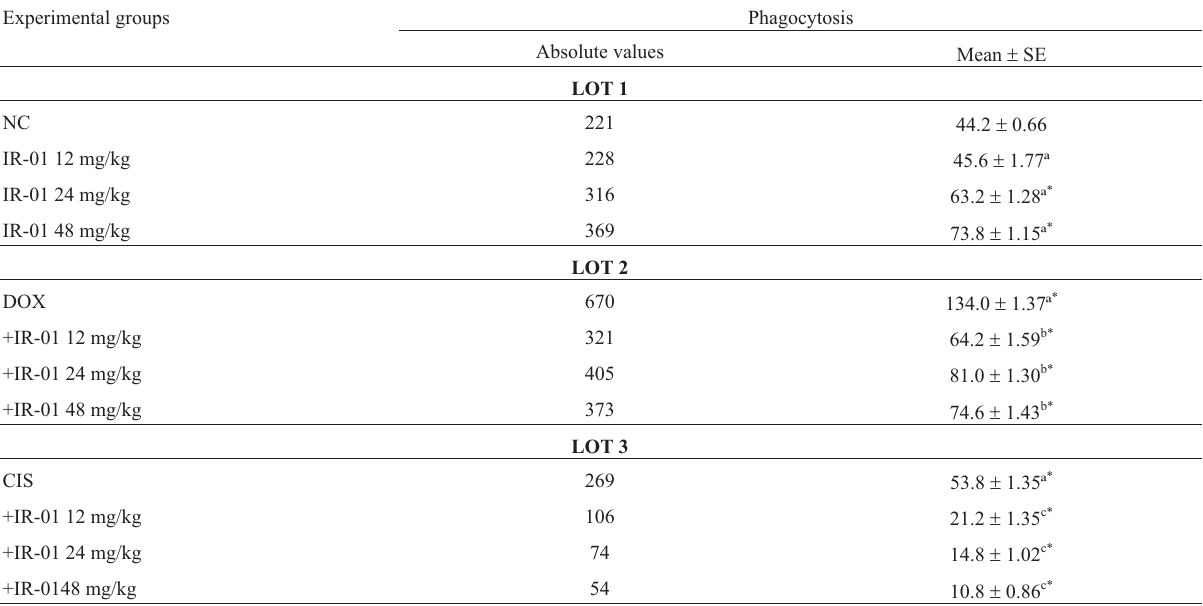
Table 3 - Results related to splenic phagocytosis